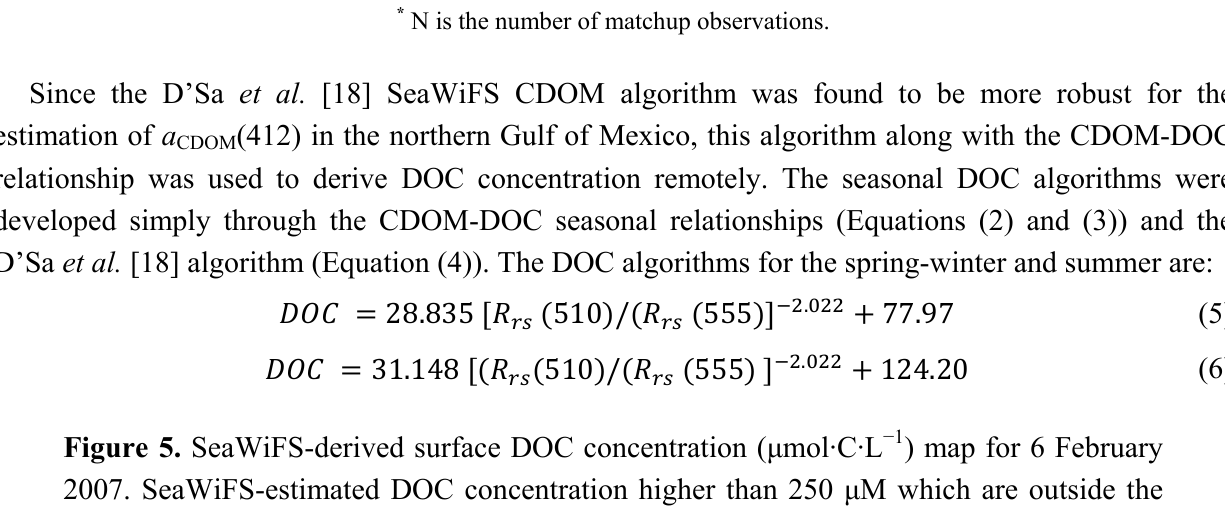
Table 5. Summary of error statistics derived from matchup comparisons between in situ and satellite-derived a (412) obtained from D’Sa et al. [18] and LM algorithms. CDOM R Band Ratio R 2 RMSE Bias SI Slope Intercept N * rs R 510/R 555-D’Sa et al. (2006) algorithm rs rs